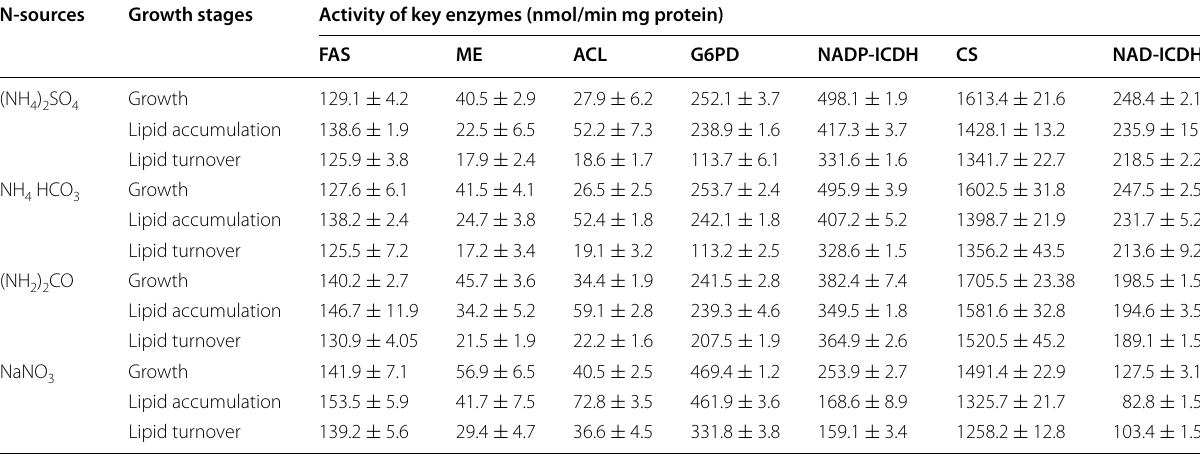
All experiments were performed in triplicate. The data presented here is mean